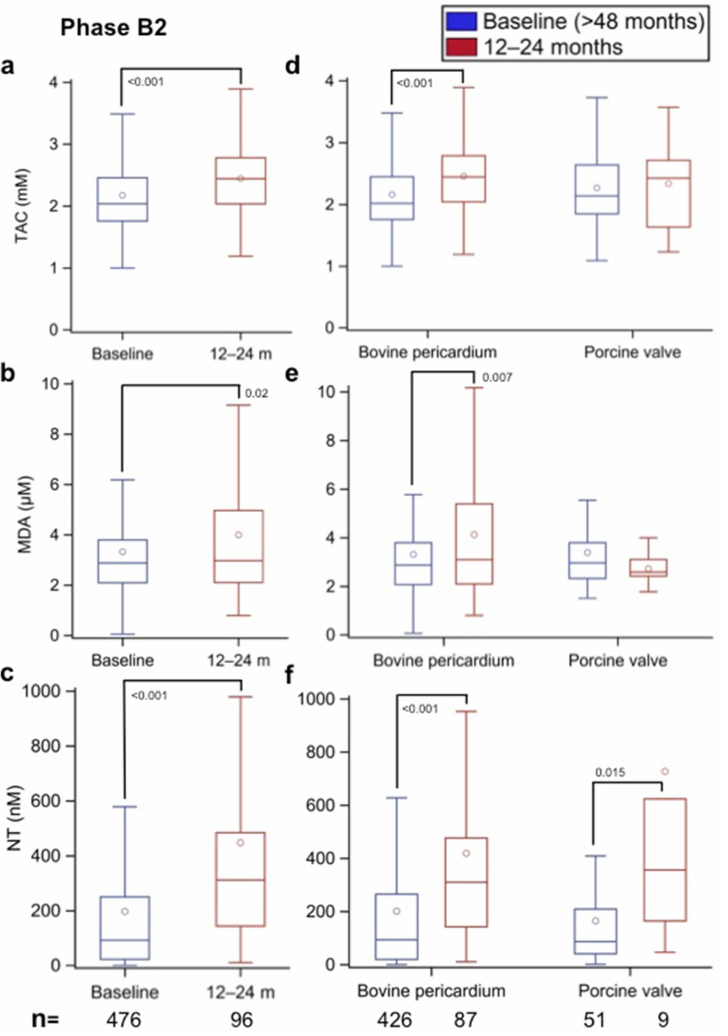
Figure 6. ( a , d ) Total antioxidant capacity (TAC, in mm), ( b , e ) malondialdehyde (MDA, in µ m), and ( c , f ) nitrotyrosine (NT, in nm) values in Phase B2 patients with all types of implanted aortic biological heart valves (BHVs) and in Phase B2 patients with implanted bovine pericardium and porcine aortic BHVs, respectively, at the time of recruitment (>48 months after surgery) and after 12–24 months of follow-up (>60–72 months after aortic valve implantation). The numbers within the figures represent the p -values, and the numbers at the bottom of the figures represent the number of assessed patients. Multiple comparison adjustments were performed with Dunnett’s and Tukey–Kramer’s